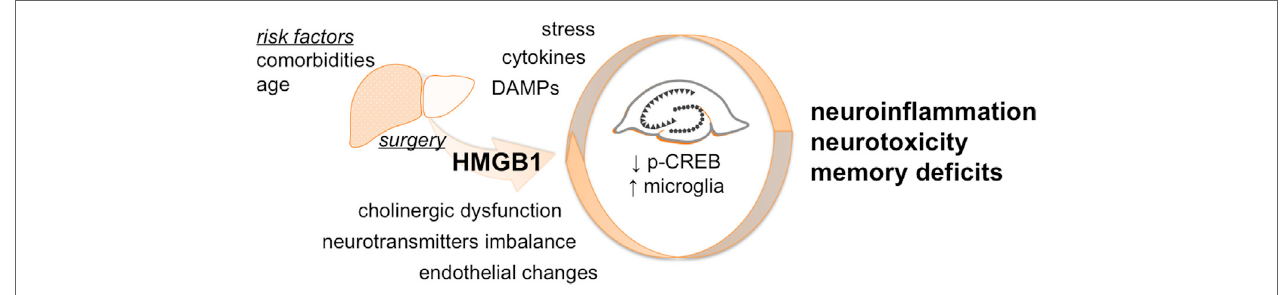
FigUre 6 | Proposed working model . Surgery triggers peripheral HMGB1 release that can gain access to the CNS contributing to neuroinflammation. The effects of HMGB1 in the CNS are not limited to microglia activation but also involve modulation of p-CREB expression in the hippocampus. Overall, this acute neurotoxicity leads to behavioral deficits that are effectively attenuated by selective anti-HMGB1 mAb